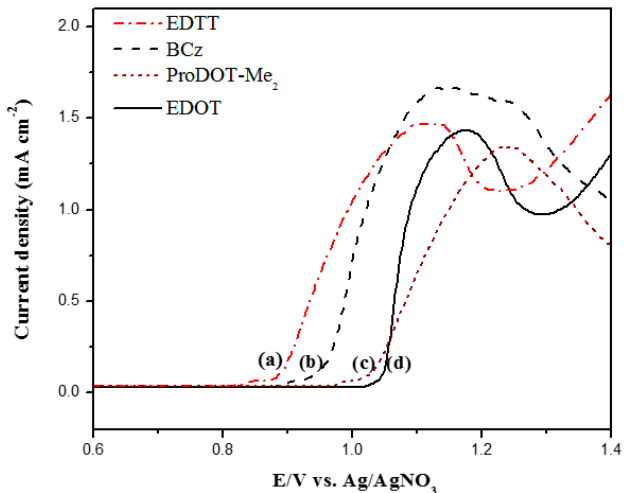
Figure 2. Anodic polarization curves of: ( a ) 2 mM EDTT; ( b ) 2 mM BCz; ( c ) 2 mM ProDOT-Me 2 ; and ( d ) 2 mM EDOT in a PC/ACN (1:1, by volume) solution containing 0.2 M LiClO 4 at a scan rate of 100 mV · s − 1